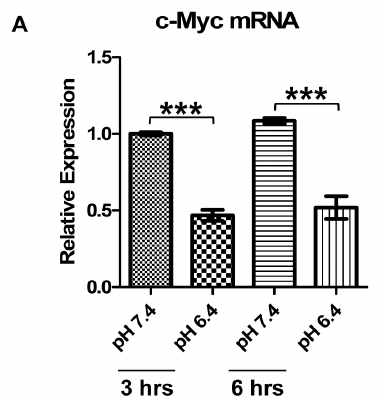
Figure 2. c-Myc transcriptional level, but not mRNA or protein stability, is downregulated by acidosis in U937 cells. ( A ) c-Myc mRNA is decreased by pH 6.4 treatment. U937 cells treated with pH 7.4 or pH 6.4 for three and 6 h were subject to total RNA isolation and real-time RT-PCR using c-Myc-specific primer probes. GAPDH (glyceraldehyde 3-phosphate dehydrogenase) was used as an internal control for normalization; ( B ) c-Myc mRNA stability is not altered by acidosis. U937 cells grown in HEM (7.5 mM HEPES, 7.5 mM EPPS and 7.5 mM MES)-buffered medium with 5 μ g/mL actinomycin D at pH 7.4 or pH 6.4 for the indicated times were subject to total RNA extraction and real-time RT-PCR using c-Myc-specific primer probes. GAPDH ( left ) and 18S rRNA ( right ) were used as internal controls. The expression of c-Myc under 15 min of pH 7.4 plus actinomycin D treatment was set as one; ( C ) c-Myc protein stability is not altered by acidosis. Left panel: U937 cells grown in HEM-buffered medium with 50 μ g/mL cycloheximide (CHX) at pH 7.4 or pH 6.4 for the indicated times were subject to total protein extraction and Western blot using anti-c-Myc antibody. β -Actin was used as a loading control. Right panel: quantification of Western blot results. The expression of c-Myc under the 15-min treatment with pH 7.4 and CHX was set as one. The data presented were derived from at least three biological replicates. Error bars indicate